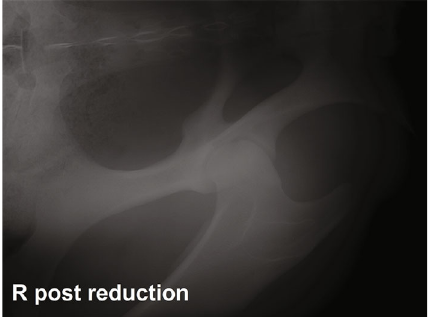
Figure 2: Ventrodorsal radiographic projection of the right acetabulum after closed reduction of the coxofemoral luxation. The right femoral head is seated in its correct position within the